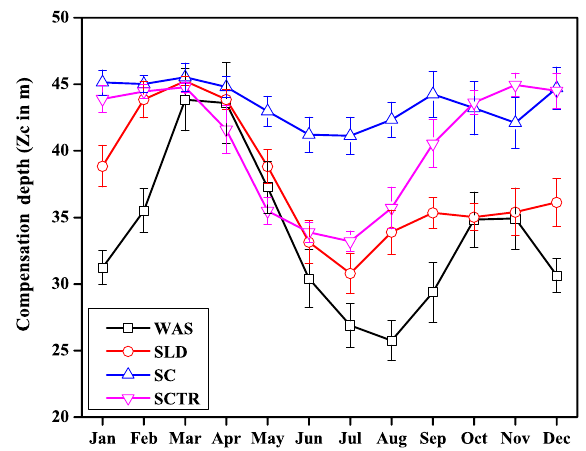
Figure 5. Seasonal variations in var Zc over the study regions shown as climatology computed over 1990–2010. Error bar shows standard deviations of individual months over these years. Units are